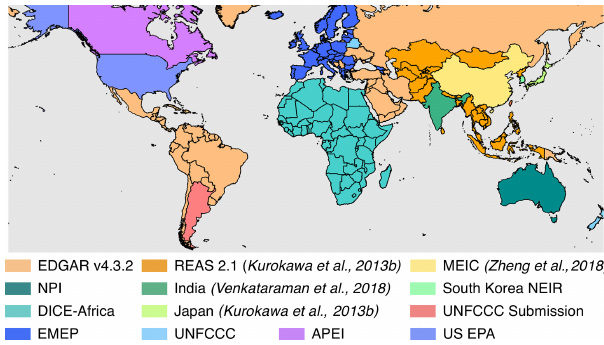
Figure 2. Final scaling inventories used for CEDS GBD-MAPS NO x emissions; inventory details in Table